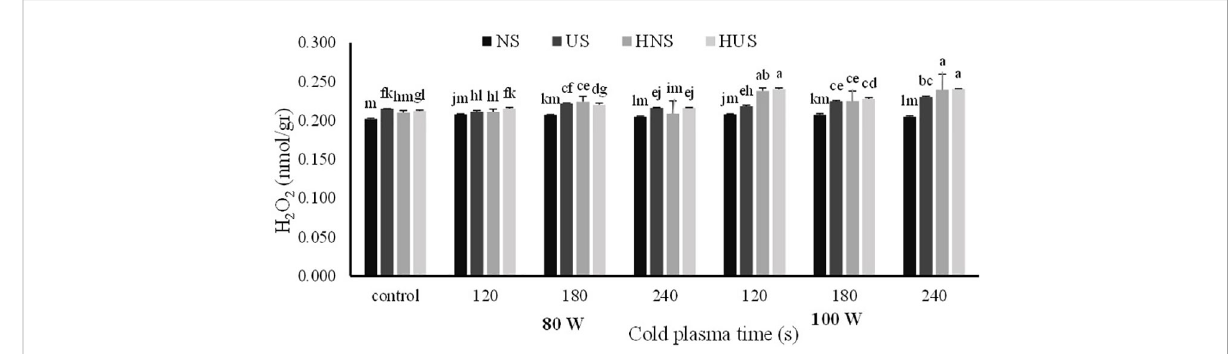
FIGURE 9 The effect of power and exposure time of cold plasma and seed situation on H 2 0 2 content of S. leriifolia germinated seeds. Normal seeds (NS), Uncovered seeds (US), Hydro-primed normal seeds (HNS) and Hydro-primed uncovered seeds (HUS). Values represent mean ± S.E. Different letters indicate signi fi cant differences at the 5% level according to the LSD